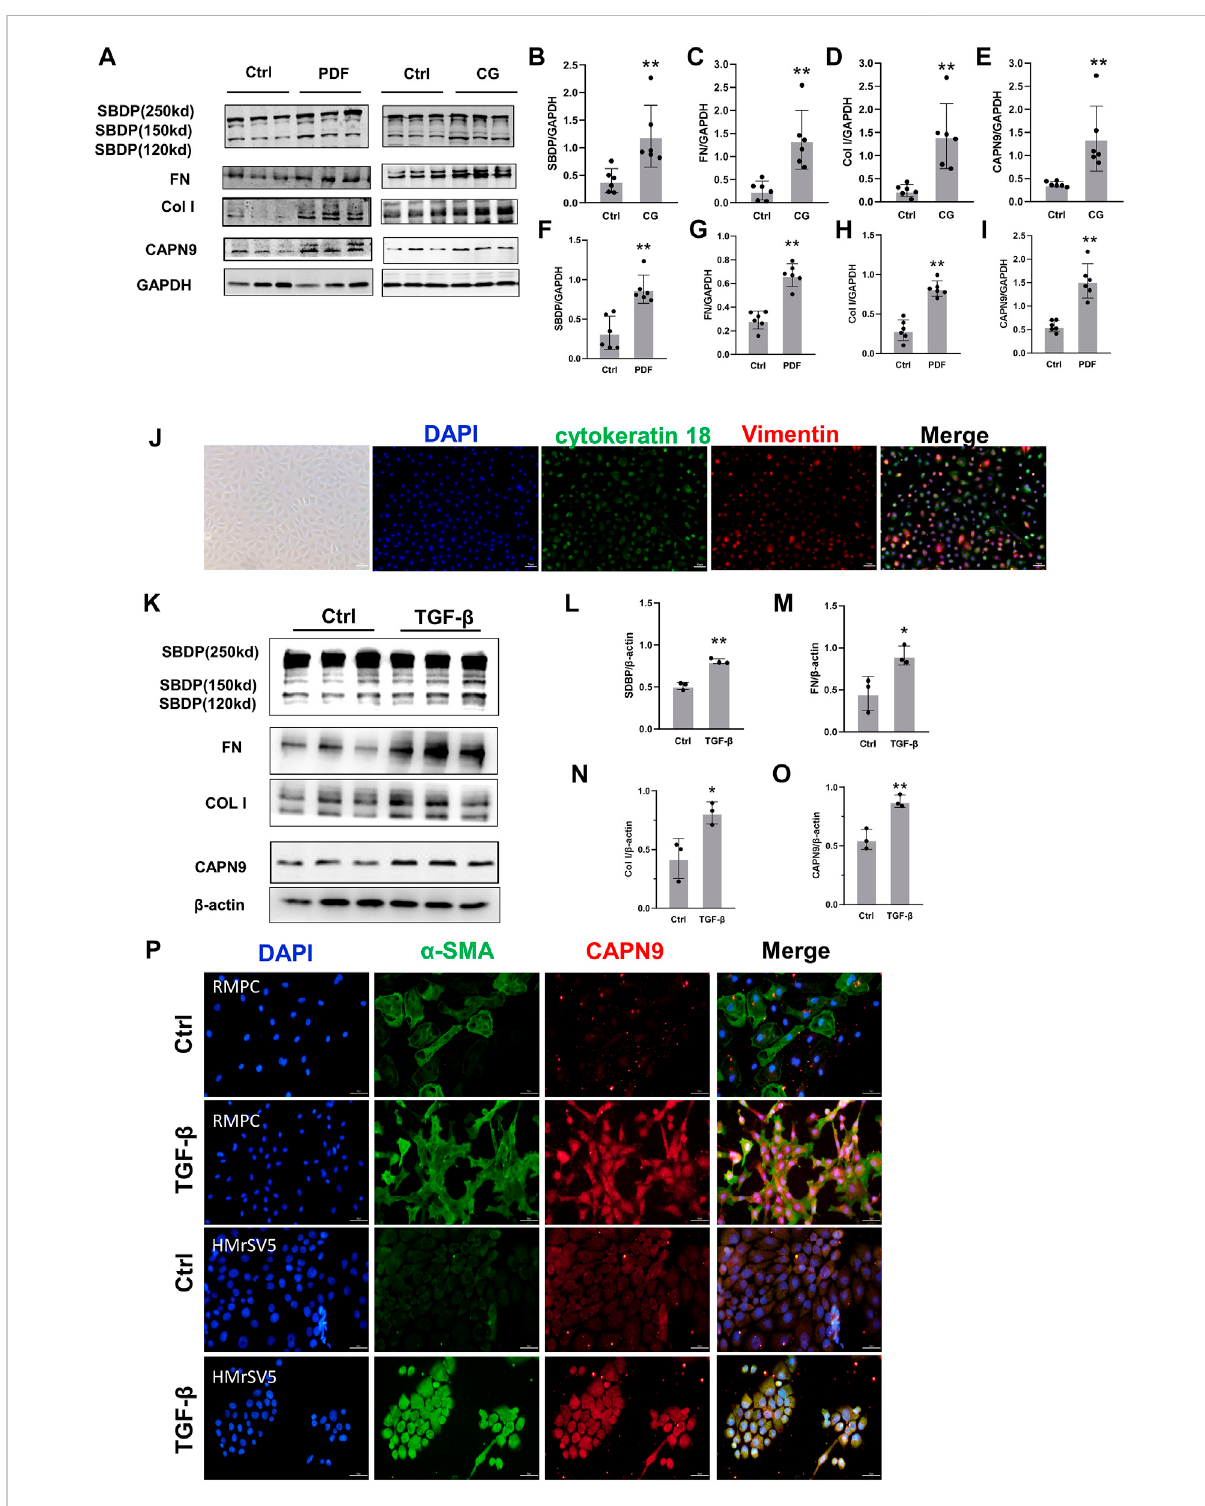
Calpain activity and calpain nine expression is increased during peritoneal fi brosis. (A) . Western blotting (WB) showing the expression of Calpain9 (CAPN9), SBDP cleavage products (120 and 150 kD), Collagen I (Col I) and Fibronectin (FN) in visceral peritoneal lysates of untreated (Ctrl), 6-week PDF (F – I) or21-dayCGtreatedmice. (B – E) SBDP (120 and150kD), FN, ColI,CAPN9 in theperitoneal wereexamined. GAPDHwas detected as loading control. Values are the mean ± s. e.m. n = 6, * p < 0.05, ** p < 0.01, vs. control (Ctrl). (J) Isolation and identi fi cation of